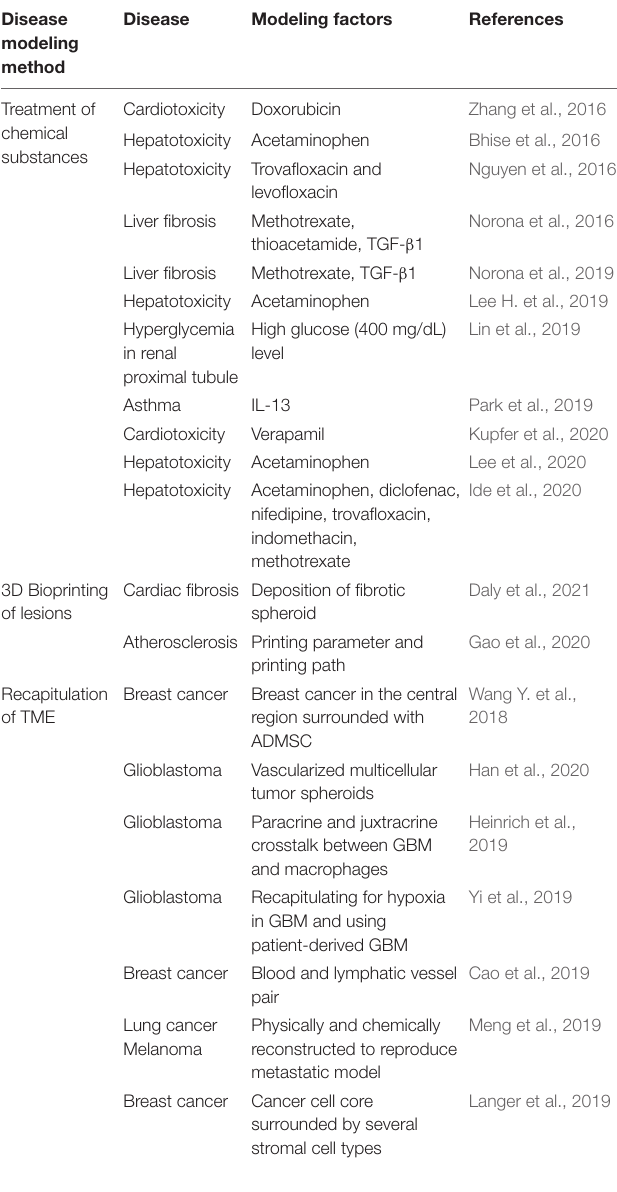
TABLE 1 | Disease modeling methods applied to 3D bioprinted in vitro